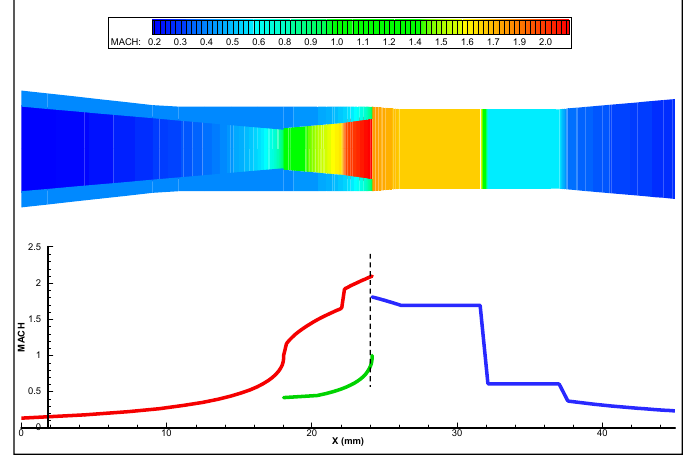
Figure 11. Idealised Mach number distribution along the ejector [41].